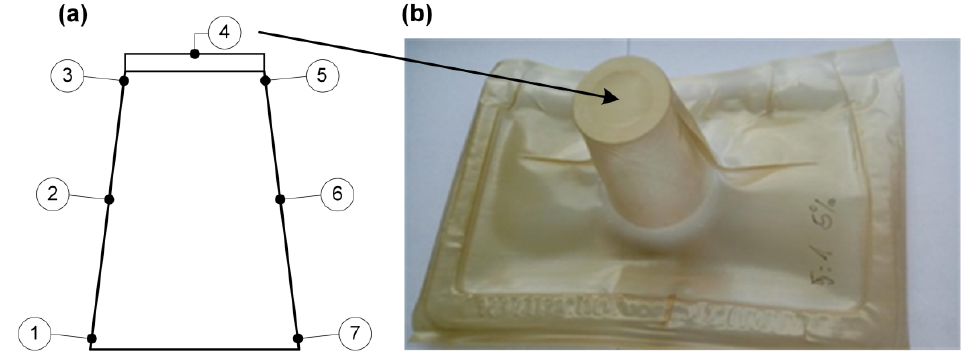
Figure 7. A drawing which illustrates point no. 4 set as a less-elongated ( a ) and thermoformed sheet with arrow indication of the top surface ( b ), where the wall thickness was close to the initial thickness of the film before the thermoforming process.